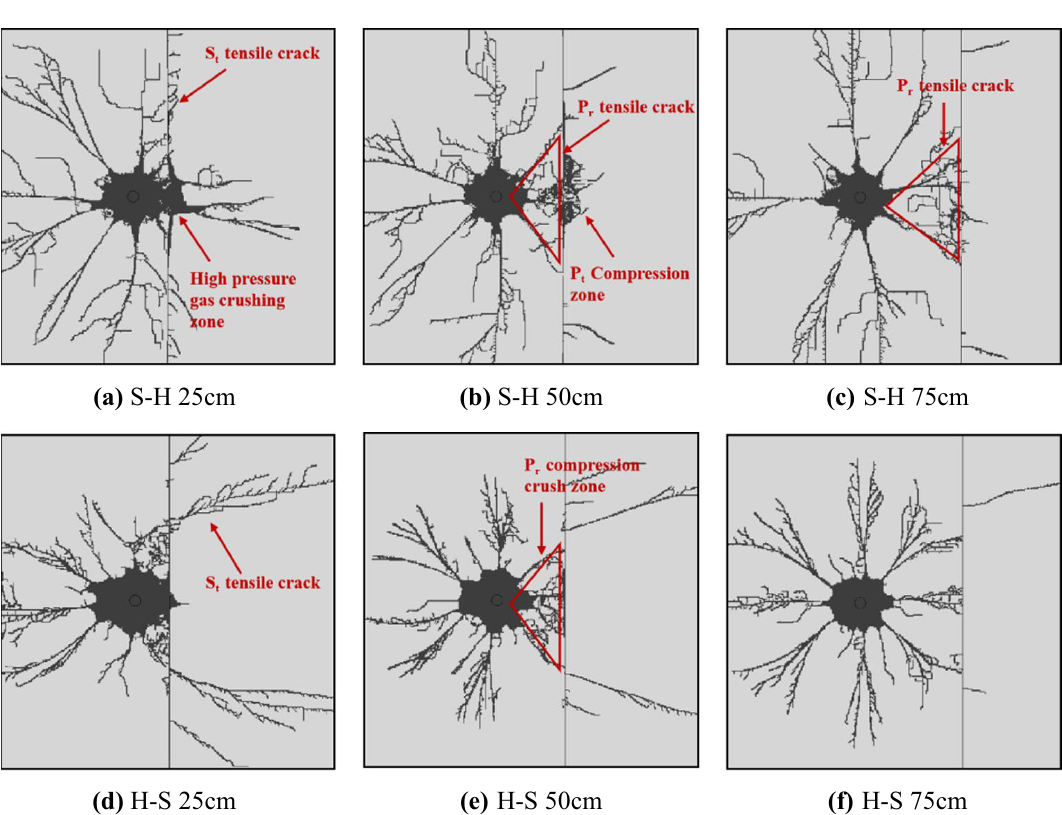
Figure 16. Crack propagation under different incidence modes of P i